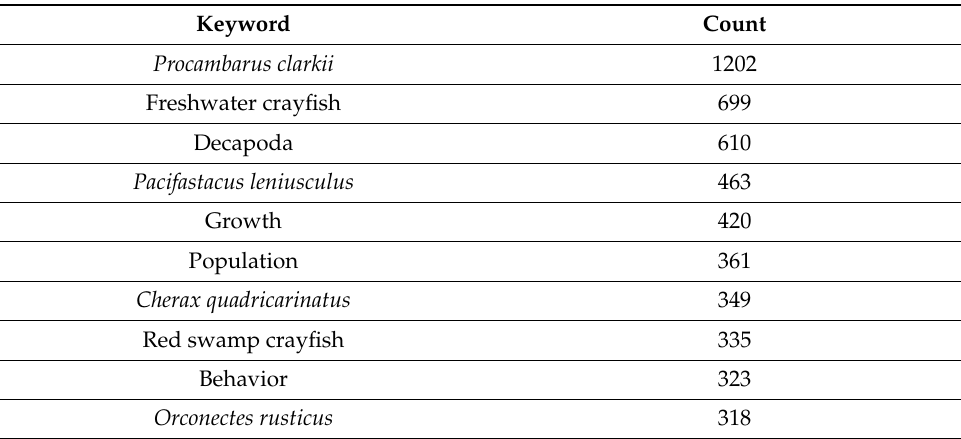
Table 9. Top 10 popular keywords in titles, abstracts, and